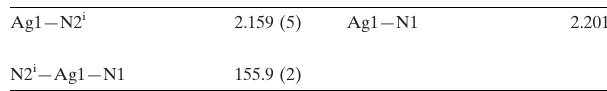
Selected geometric parameters (A˚ , (cid:4) ).